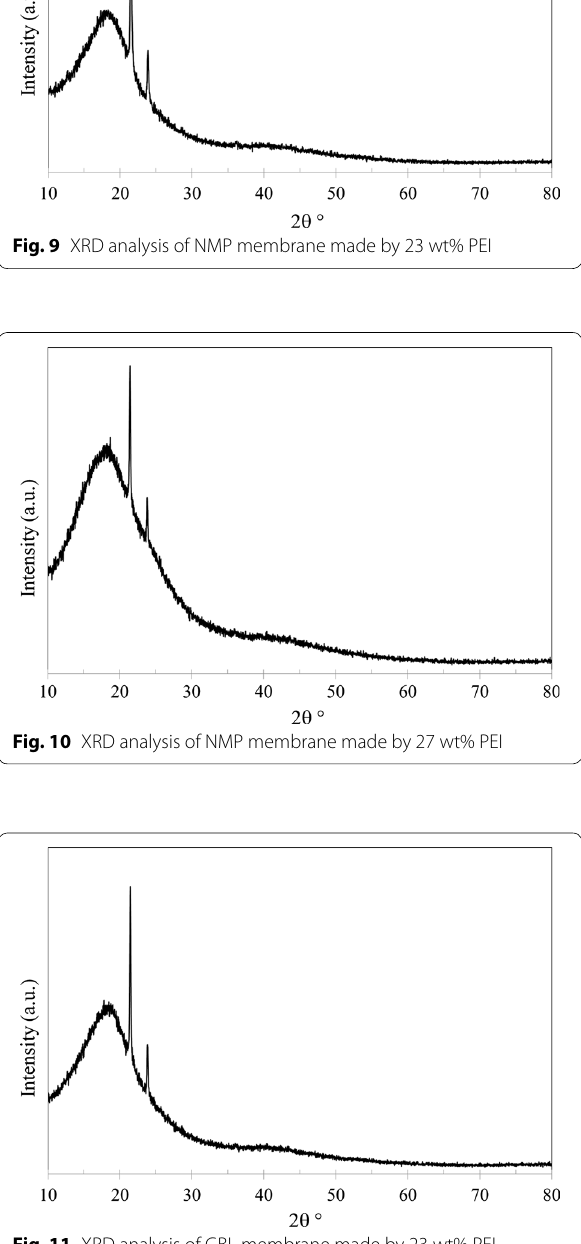
Fig. 11 XRD analysis of GBL membrane made by 23 wt%